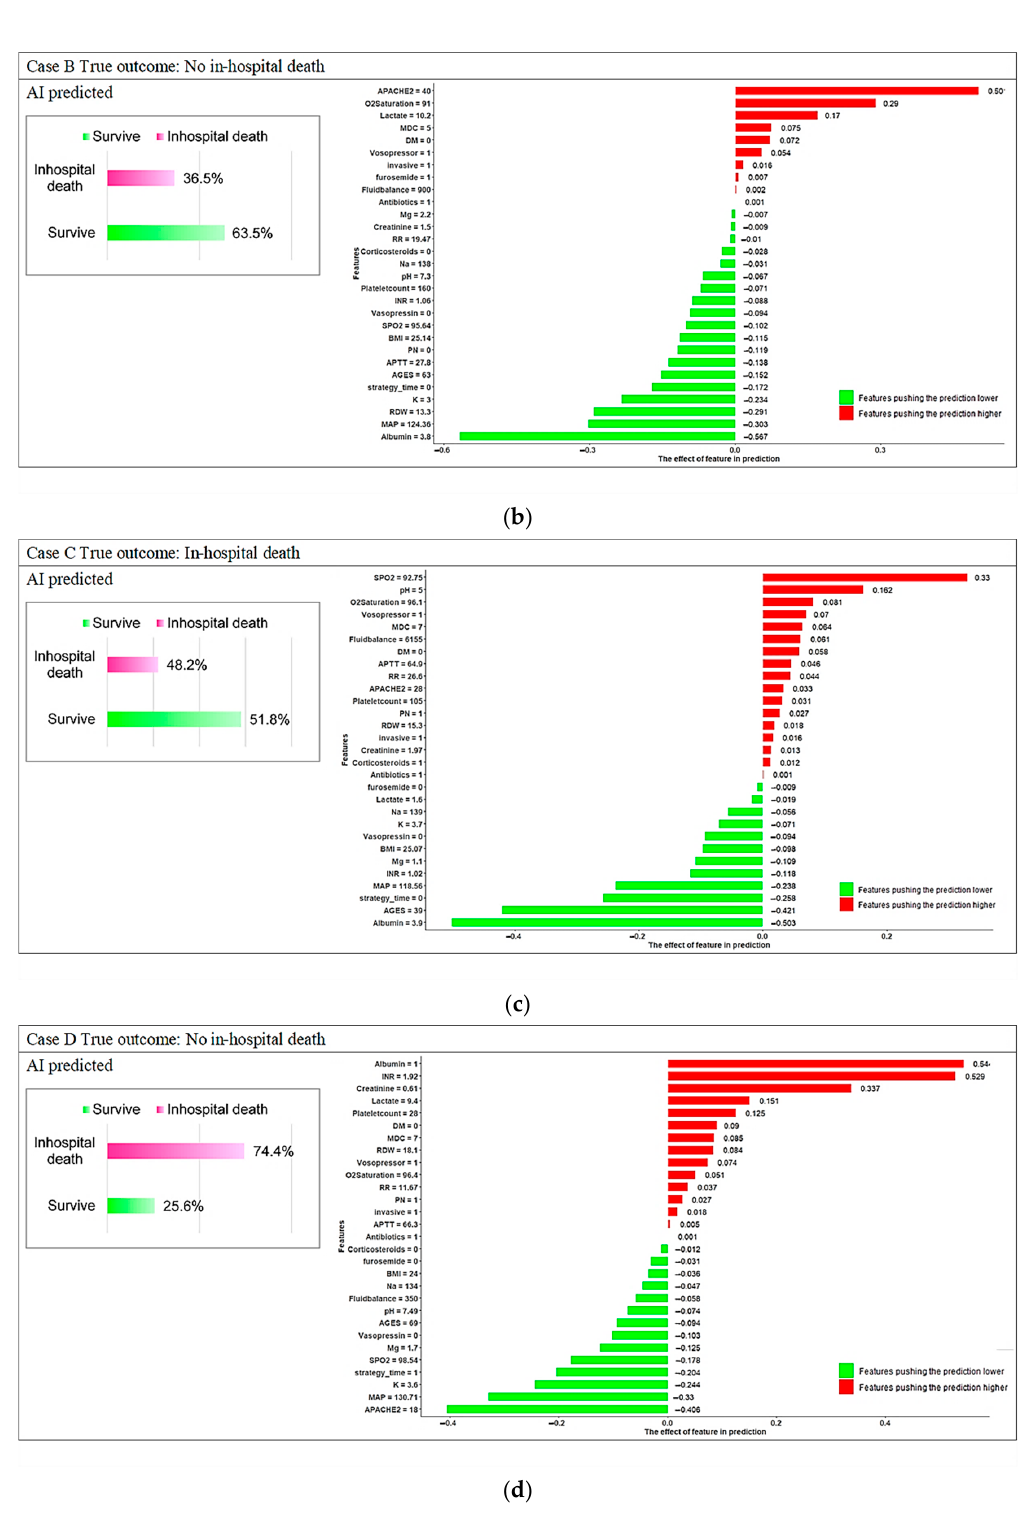
Figure 8. Local explanation plots for individuals with various in-hospital mortality statuses and XGB model predictions. ( a ) In-hospital death and AI predicted in-hospital death; ( b ) non-in-hospital death and AI predicted non-in-hospital death; ( c ) in-hospital death but AI predicted non-in-hospital death; ( d ) non-in-hospital death but AI predicted in-hospital death. Green and red bars correspond to the contribution of the features to the prediction. Green represents a negative value, which decreases the predicted value; red represents a positive value, which increases the predicted value. X -axis represents model prediction value; y -axis lists the features and their observed